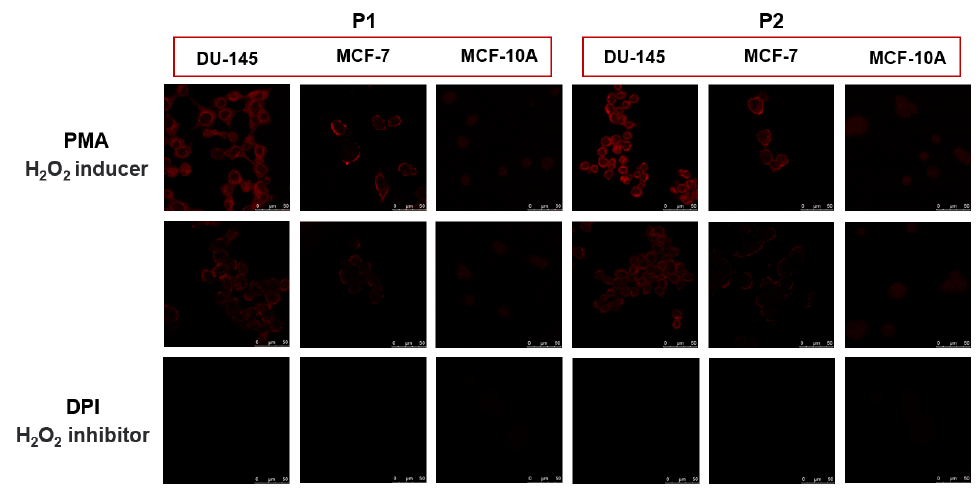
Figure 4. P1 – P2 (10 µ M) showed responsiveness to H 2 O 2 in MCF-10A, MCF-7, and DU-145 cells. PMA: H 2 O 2 inducer; DPI: H 2 O 2 inhibitor. Incubation time: 15 min. Excitation: 488 nm, emission: 600–700 nm.